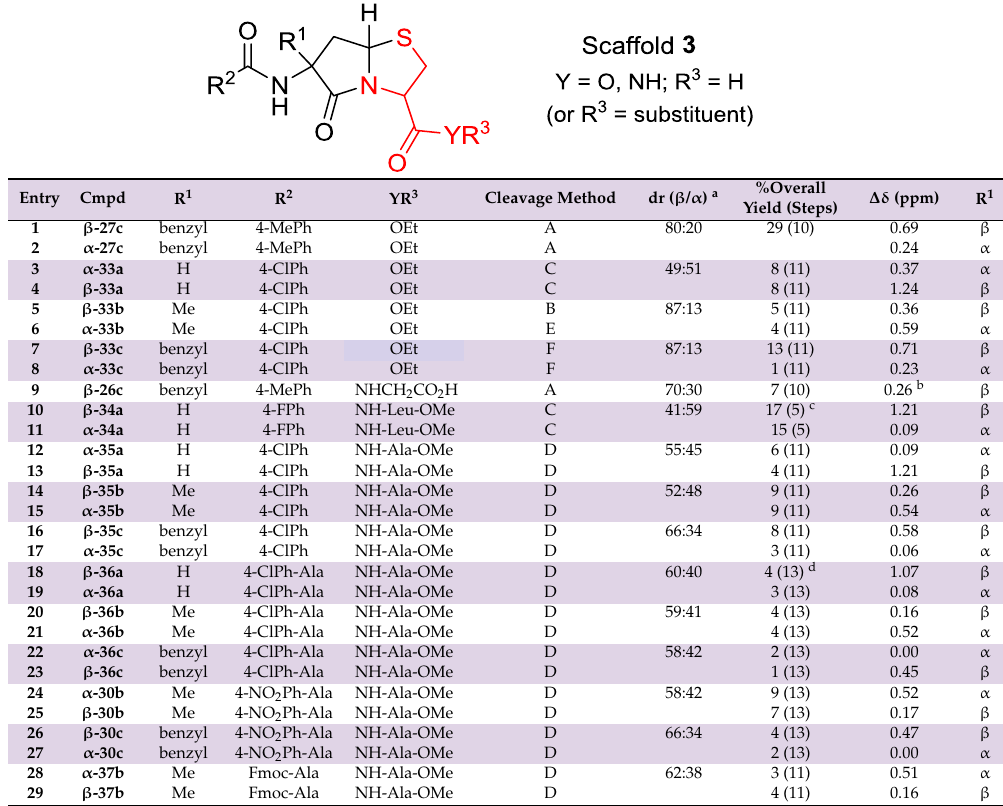
Table 2. Bicyclic Lactams 3 .